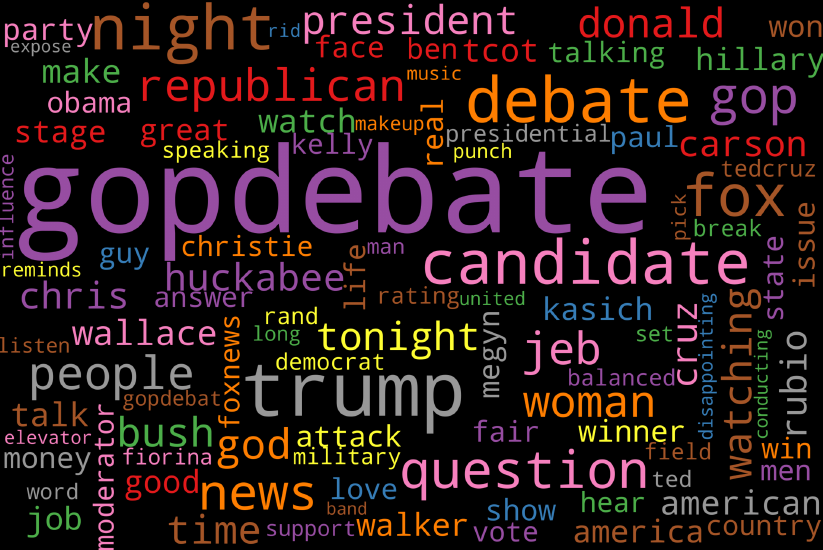
Figure 3. Dataset word cloud based on TF-IDF to determine the most characteristic